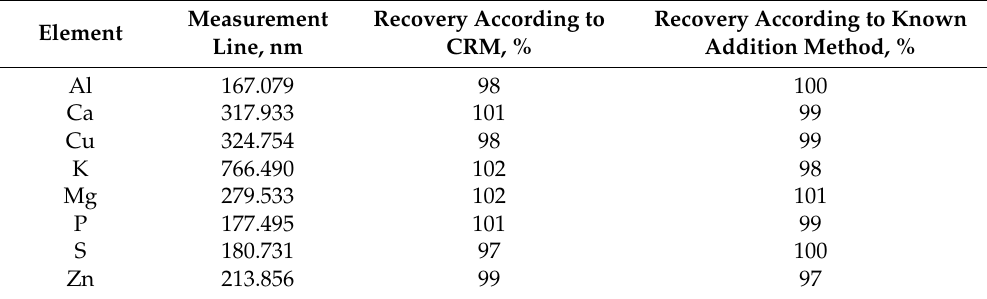
Table 8. Measurements parameters and recovery for specific